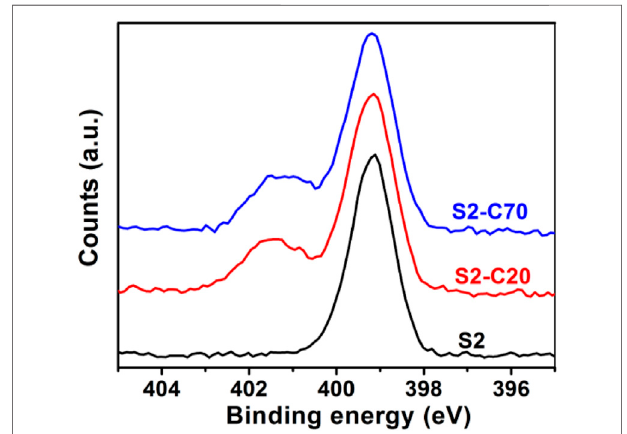
FIGURE 3 | Nitrogen 1s regions of XPS spectra for sample S2, (bottom) non-crosslinked BCP NPs, (middle and top) crosslinked BCP NPs at target PVP CLDs of 20% (middle) and 70%